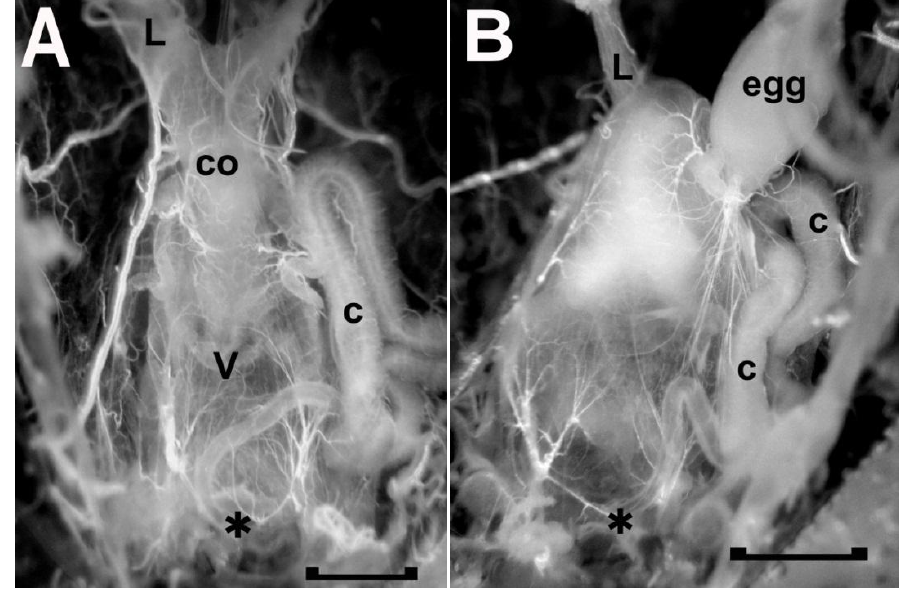
Figure 7. The freshly dissected female reproductive tract of two adult Rhodnius prolixus , one without (A) and one with (B) a spermatophore in the vagina (v). As seen in A, the anterior end of the vagina is attached to the common oviduct (co), which, in turn, leads to the two lateral oviducts (L, left lateral oviduct). The presence of a spermatophore, as seen in B, obscures the common oviduct as the spermatophore expands the vagina anteriorly. The spermatophore mainly consists of transparent material with opaque material at the anterior end next to the opening to the common oviduct. C, secretory portion of cement gland; asterisk, vulva and location where the duct of the cement gland secretes the cement onto the passing egg; egg, mature egg in base of right oviduct. Scale bar, 0.5 mm.